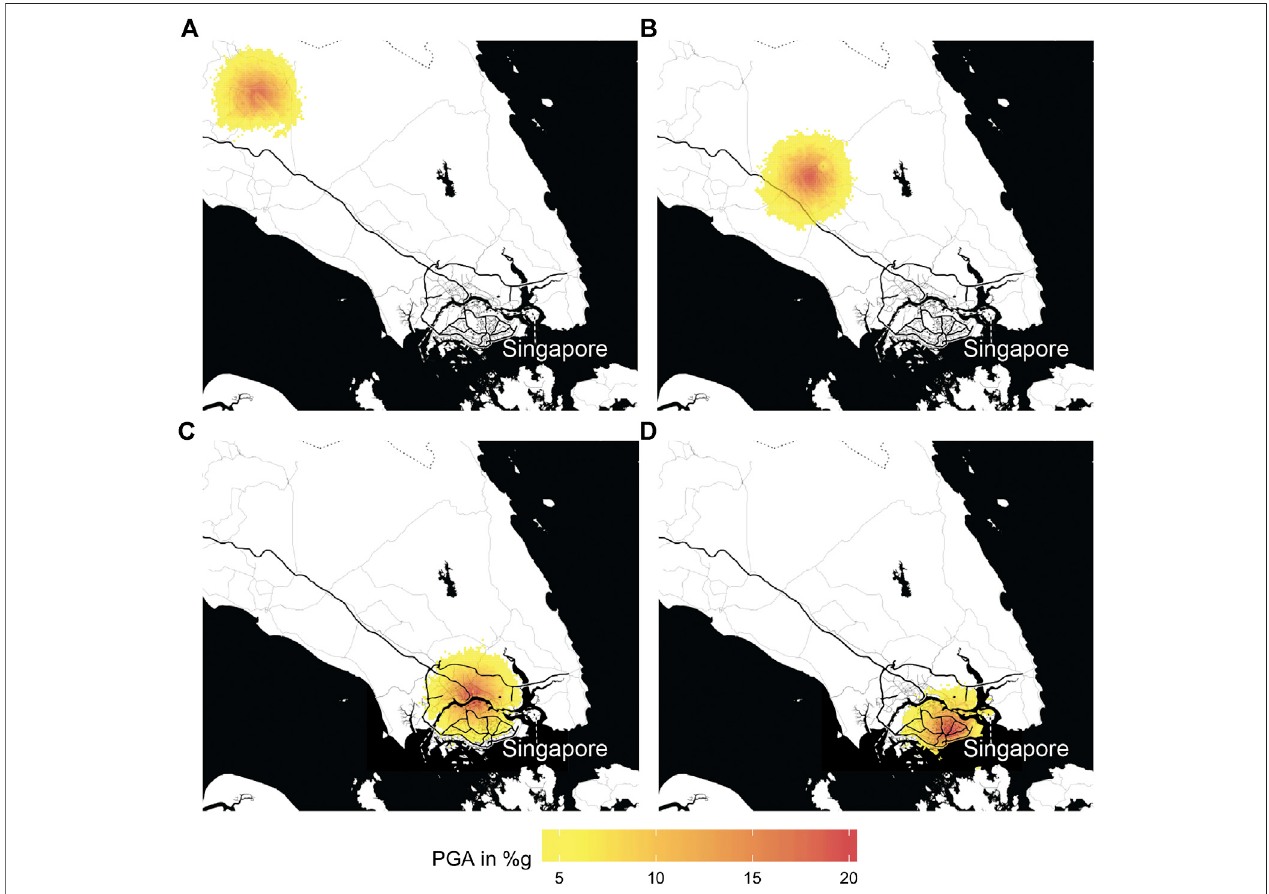
FIGURE 5 | (A) Results of the simulated Peak Ground Acceleration (PGA) of a hypothetical earthquake parameters (M4.6, depth 10 km) in southern Malaysia at 2.33 o N, 102.90 o E, based on evidence of an event in this region in 1922. This is the counterfactual seed event. The color legend is shown for all PGA values that exceed currentdesignlevel PGA4.5%gforgroundtypeD, acommon groundtype inSingapore. Wede fi neanylocationwhere thesimulatedPGAexceeds thisthreshold asthe regionthatcouldbeaffectedbysuchanevent.Thecolorscaleisthesameinallfoursub fi gures. (B) Thesameearthquakeparametersatacounterfactuallocationof 1.98 o N, 103.30 o E. This counterfactual earthquake is closer to Singapore but not yet affecting Singapore. (C) Another counterfactual location of 1.48 o N, 103.80 o E. This counterfactual event is located in Johor Bahru, Malaysia, and the potentially affected region spans most of Singapore. (D) The fi nal counterfactual event in this